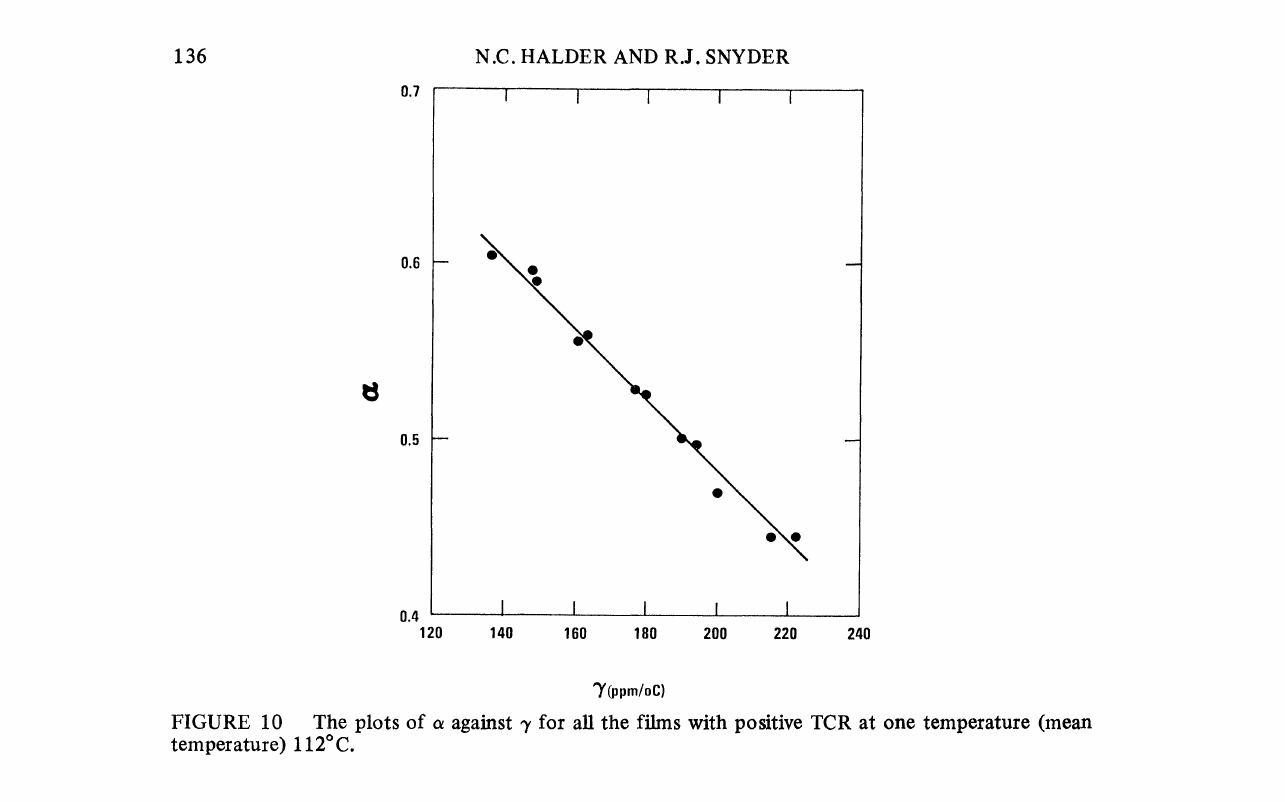
FIGURE 10 The ptots of against for all the films with positive TCR at one temperature (mean temperature) 112